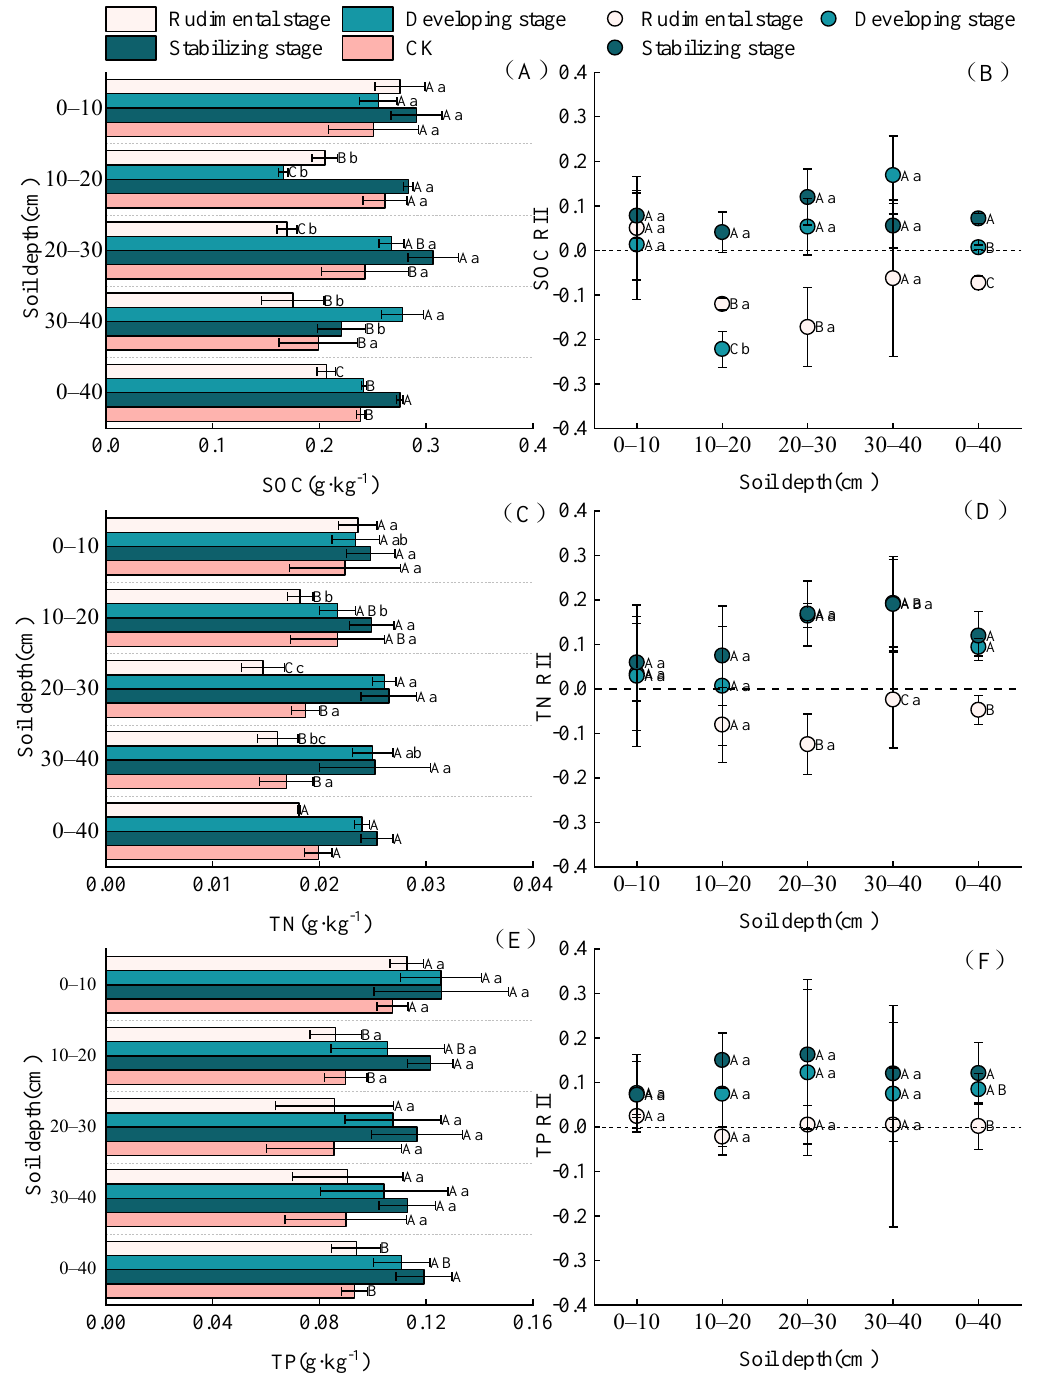
Figure 1. Soil nutrient content in nabkha. Capital letters indicate significant differences among different types of soil at the same depth ( p < 0.05). Lowercase letters indicate significant differences among soils of the same type at different depths ( p < 0.05). CK from an open area away from the nabkhas and surrounded by no plant growth. The same is given below. ( A ) Soil organic carbon (SOC), ( B ) soil organic carbon relative interaction intensity (SOC RII), ( C ) total nitrogen (TN), ( D ) total nitrogen relative interaction intensity (TN RII), ( E ) total phosphorus (TP), and ( F ) total phosphorus relative interaction intensity (TP RII).